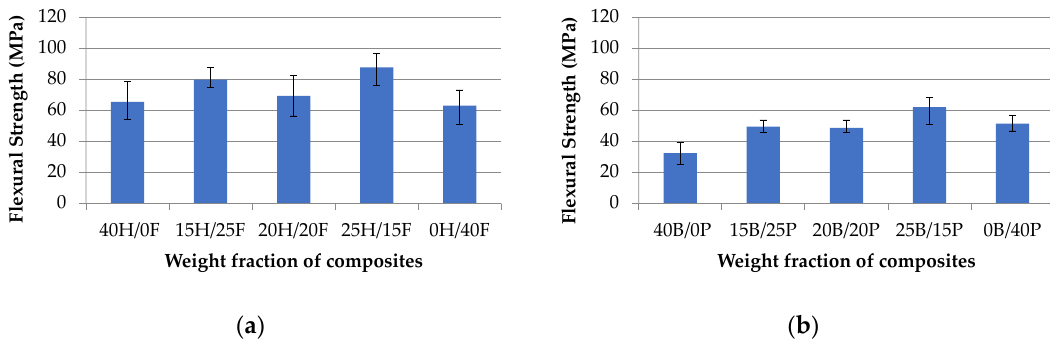
Figure 7. Flexural strength vs. weight fraction of H/F composites ( a ) and B/P composites ( b ).